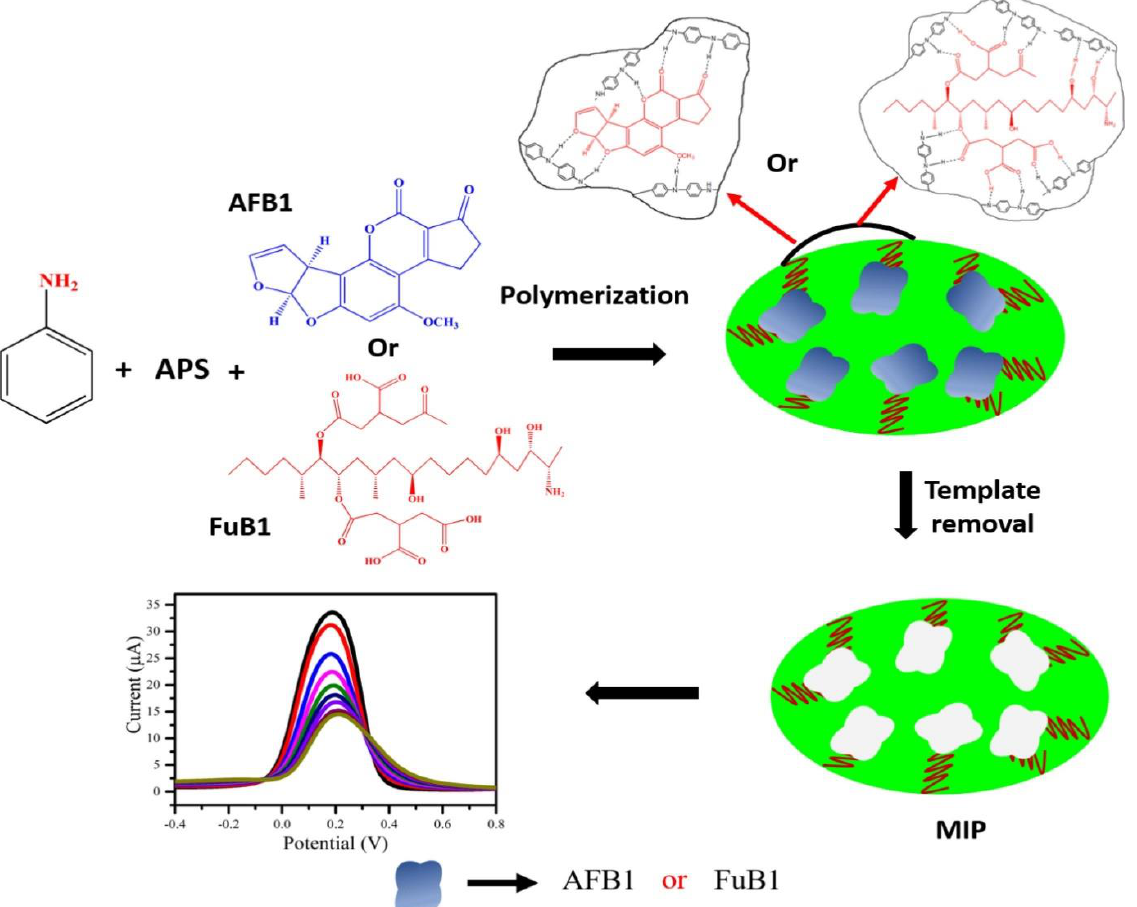
Figure 7. Schematic preparation of the MIP-based electrochemical sensing platform. Adapted with permission from Ref. [21] . Copyright 2021, Elsevier.